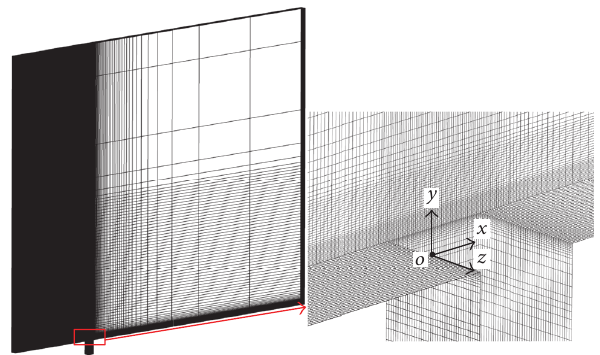
Figure 3: Computational grids for cavity flow with 𝐷/𝐿 = 2.5 (every second grid line is shown).